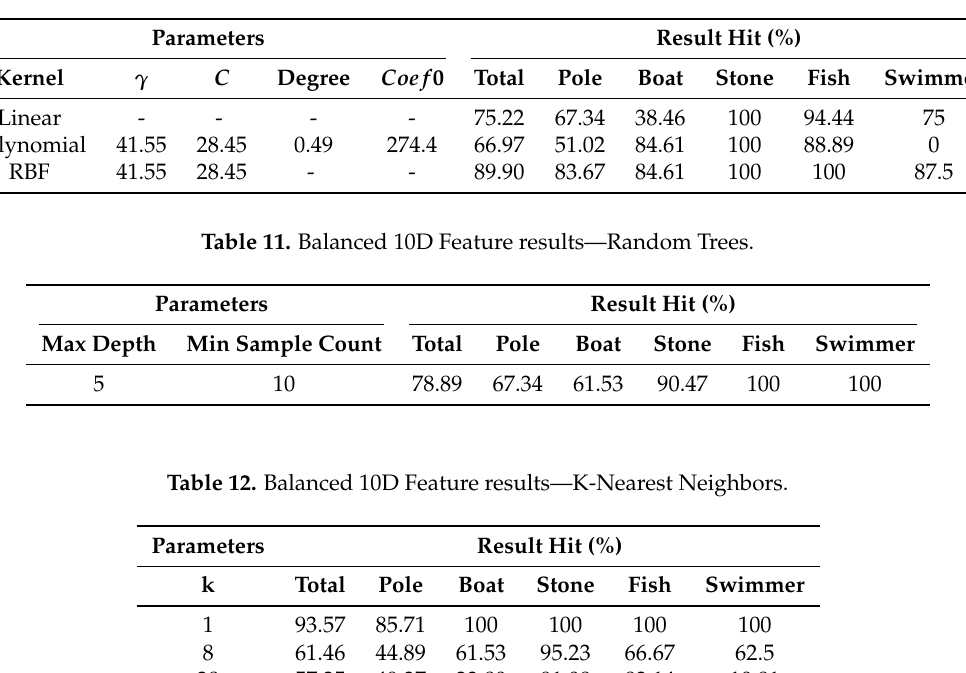
Table 10. Balanced 10D Feature results—Support Vector Machine.